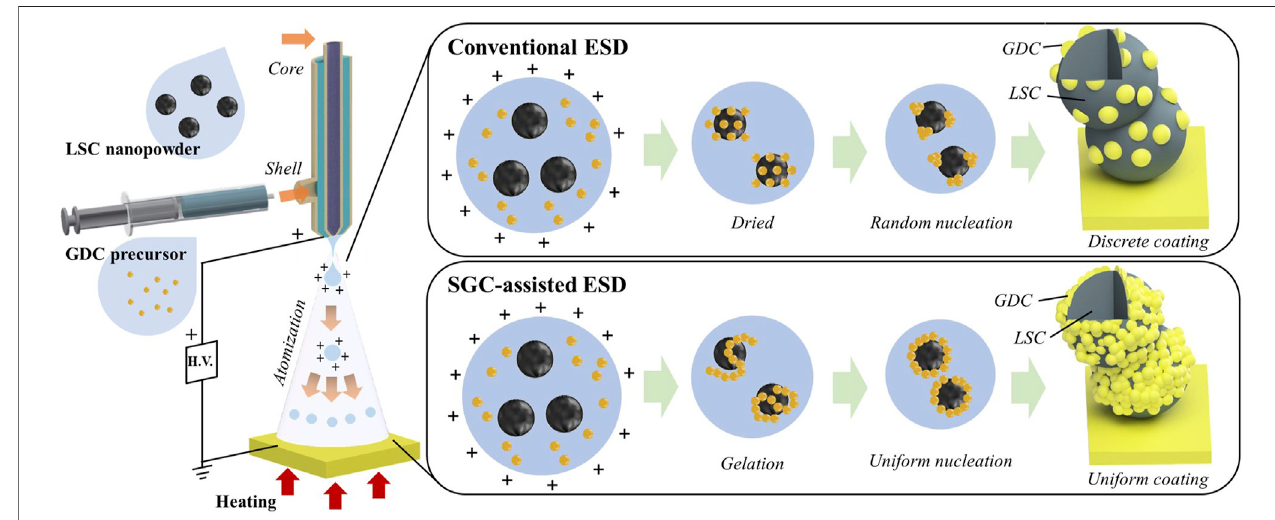
FIGURE 1 | Process schematic of conventional ESD and sol-gel combustion-assisted